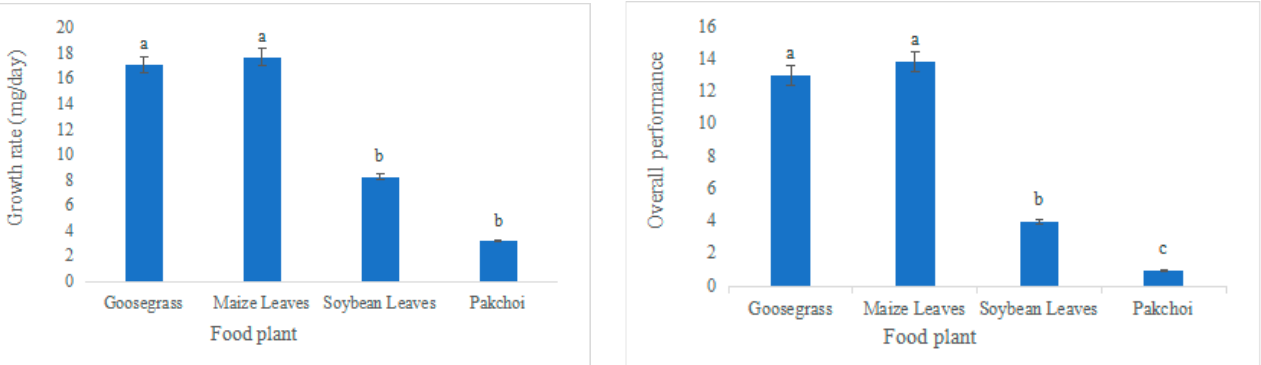
Figure 2. Growth rate and overall performance of Locusta migratoria manilensis reared on four food plants. Bars marked by different lowercase letters are significantly different based on Turkey’s HSD analysis at p < 0.05.